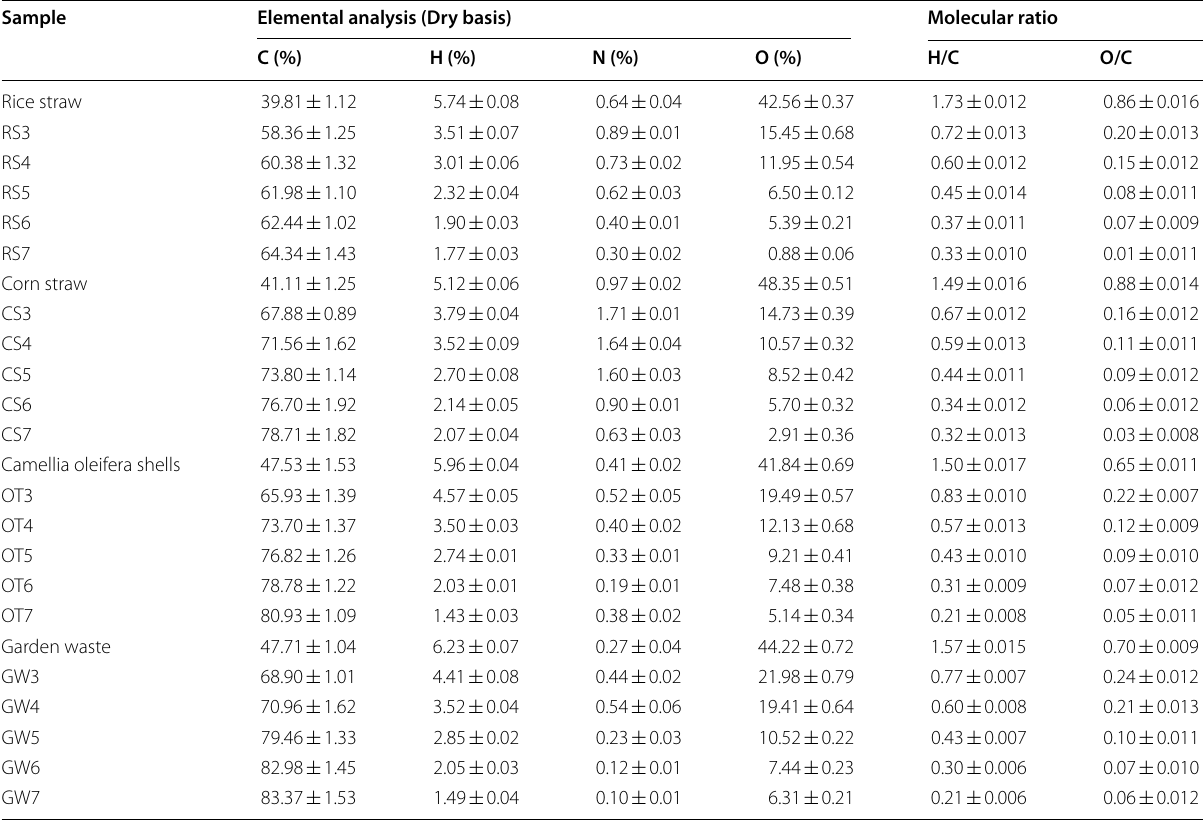
Table 1 Different pyrolysis temperatures and elemental content of biochar Sample Elemental analysis (Dry basis) Molecular